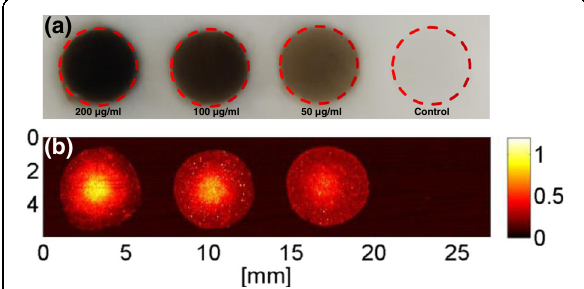
Fig. 12 Evaluations on PA responses of FePt@PPy NPs at various concentrations: a phantom and b corresponding PA